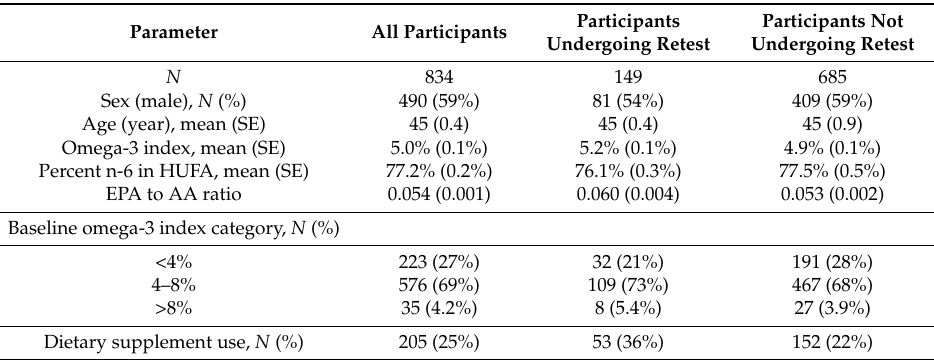
Table 1. Characteristics of participants at baseline.